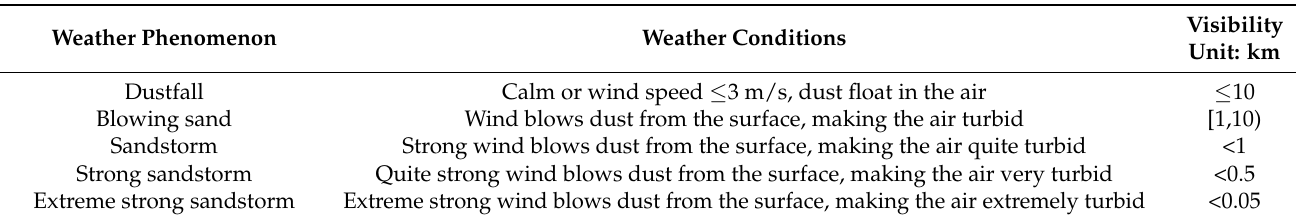
Table 2. Dust weather grade standard [52].